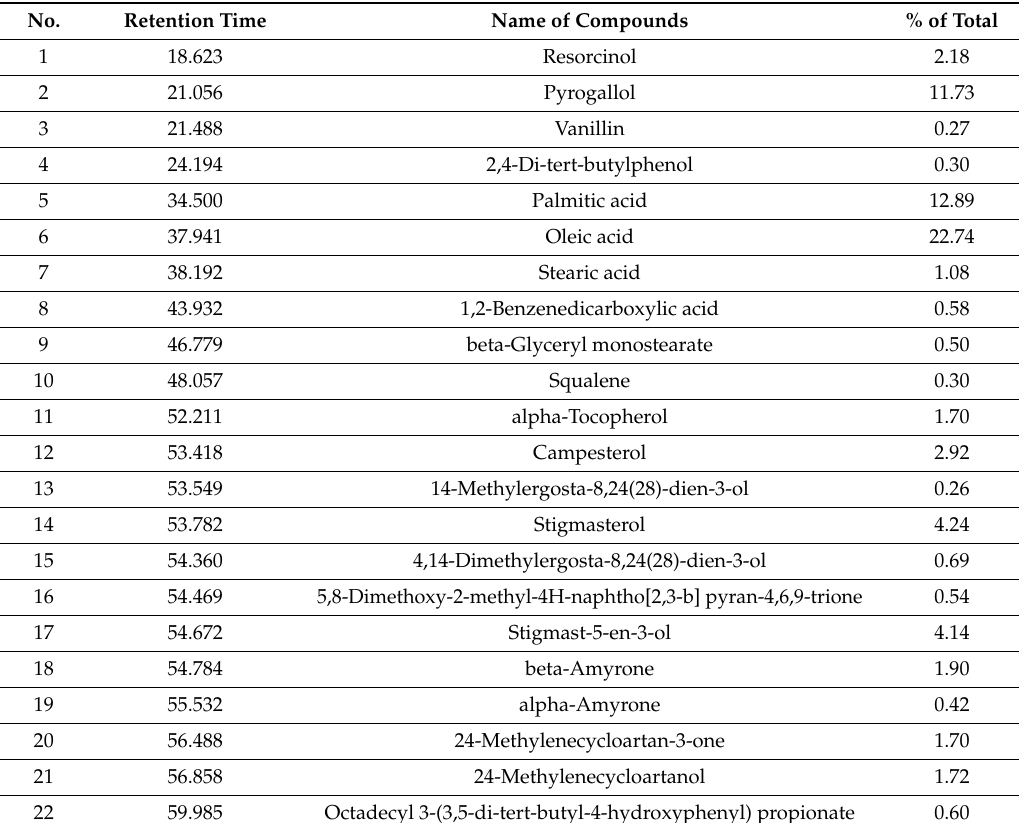
Table 4. Retention time, name, and percentage of the total of the enabling identification compounds from